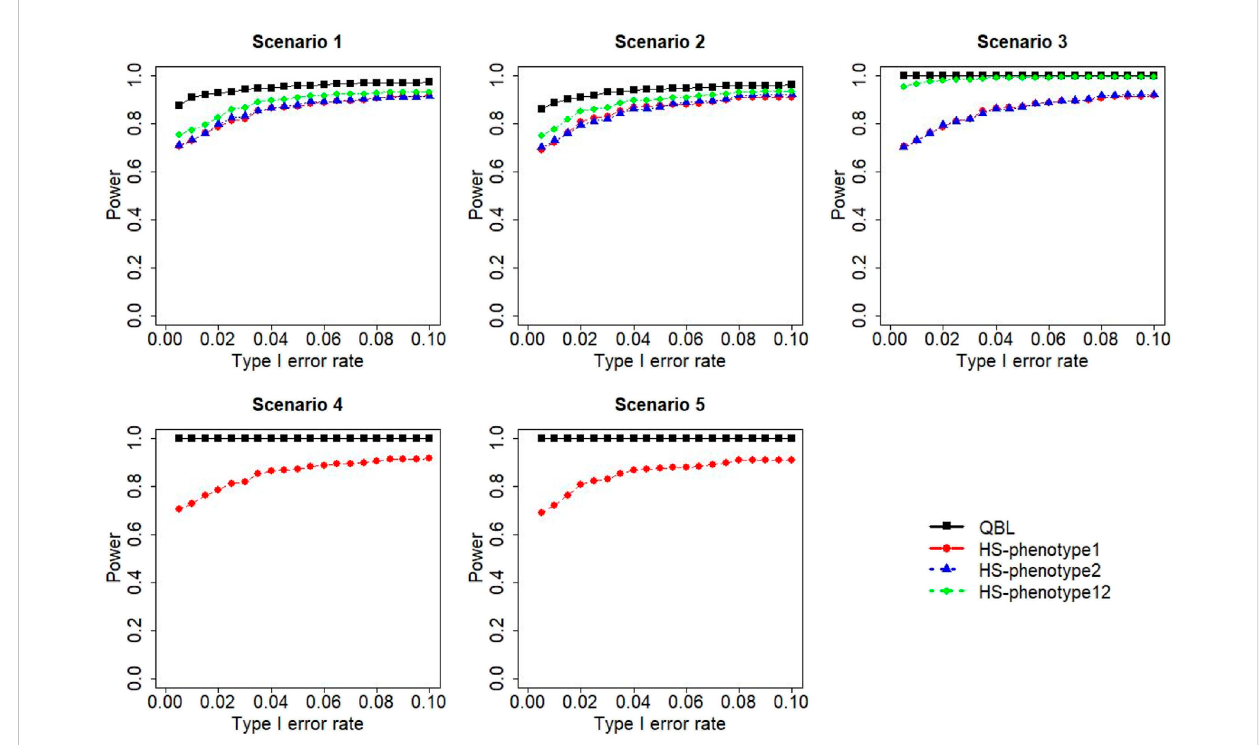
FIGURE 6 Simulation results under sample size 1,000, setting 1 (six haplotypes), and ρ = 0.9. Scenarios are shown in Table 1. HS, Haplo.score; phenotype12, phenotype 1 or